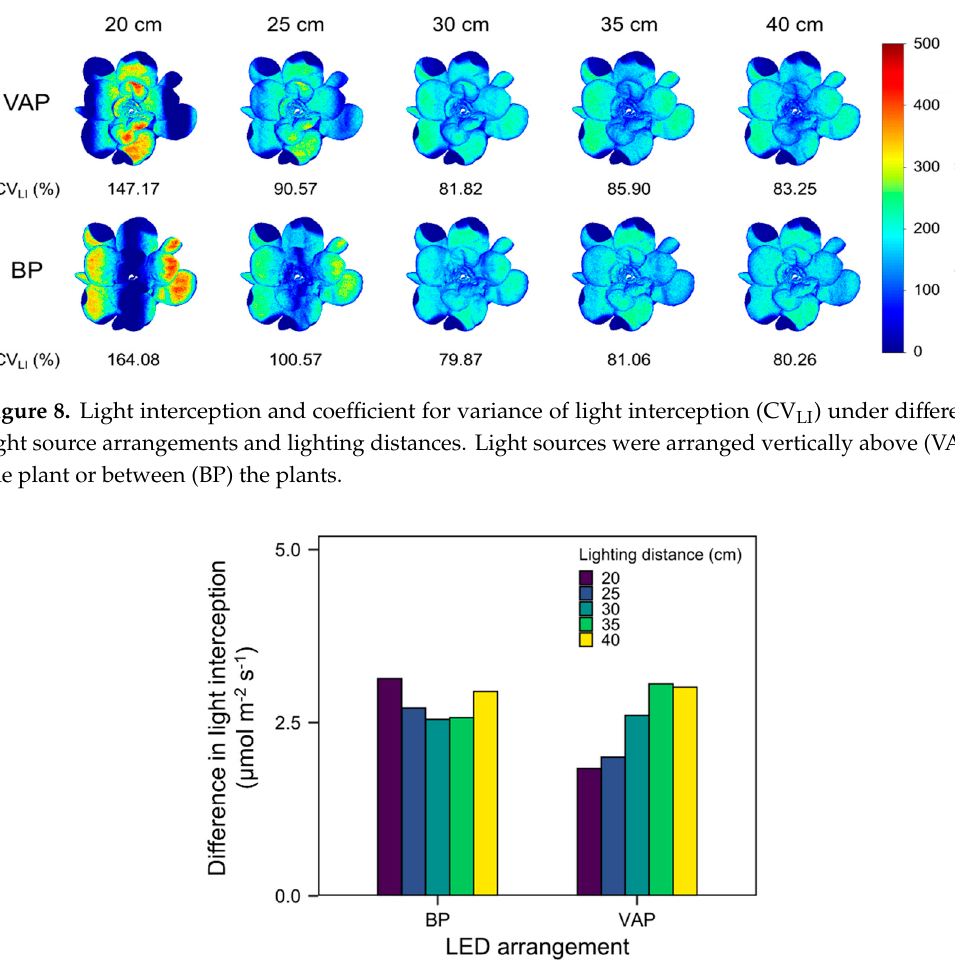
Figure 9. Difference in light interception when floor surface is changed from non-reflective to high-reflective material at different light arrangements and lighting distances. Light sources were arranged vertically above the plant (VAP) or between the plants (BP).